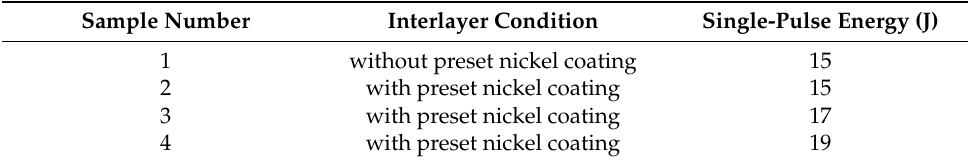
Table 2. Experimental conditions of different samples.